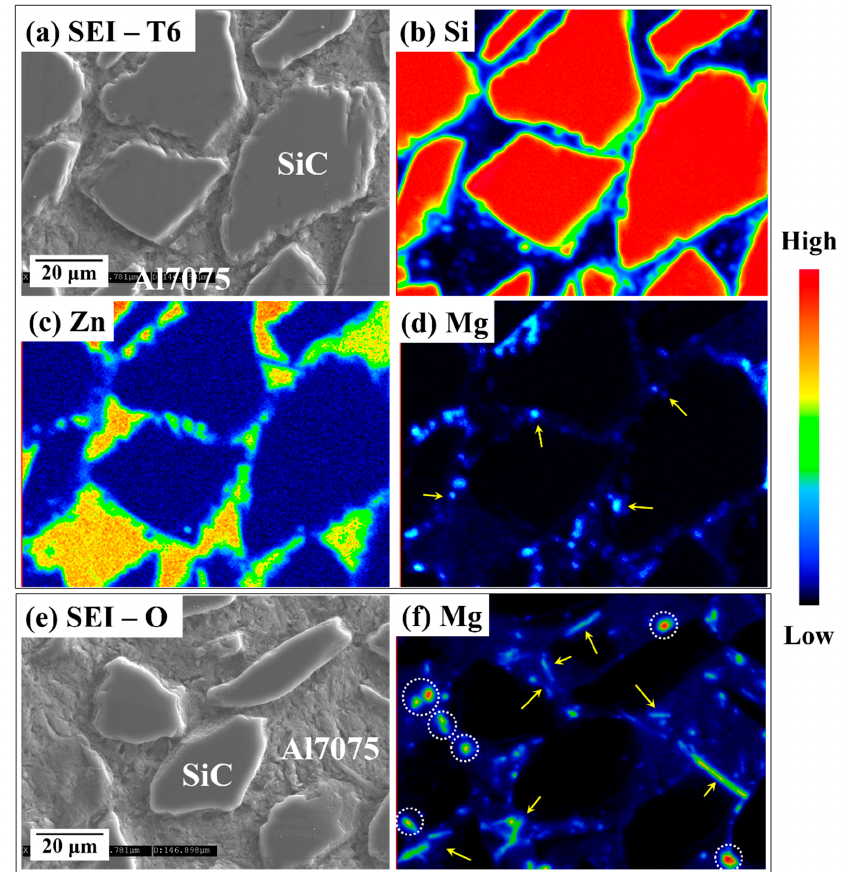
Figure 5. ( a ) Secondary electron imaging (SEI) of the MS24 composite after T6 heat treatment; ( b – d ) EPMA analysis of the element distribution map of the area in ( a ); ( e ) SEM image of as-annealed MS24; and ( f ) Mg element